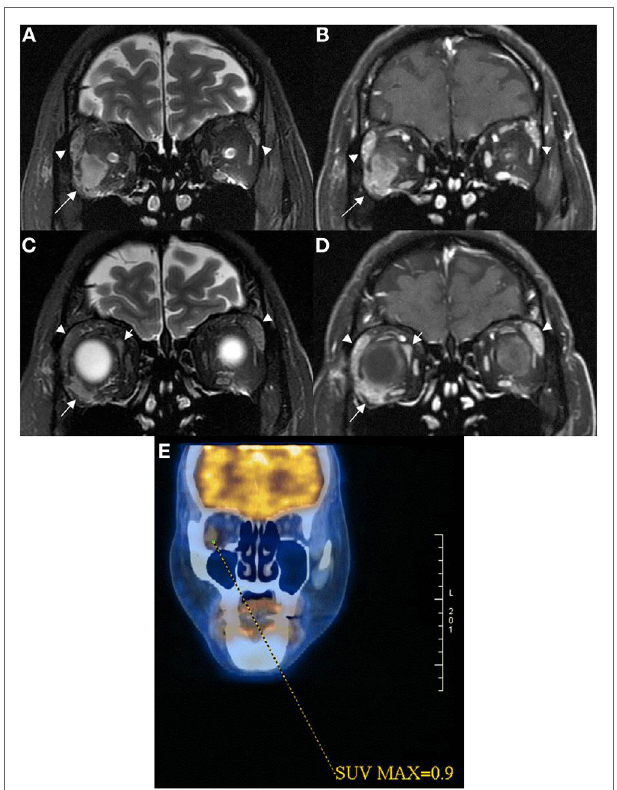
FIGURe 2 | Coronal MRI of patient 2 showed intraconal orbital mass lesion (arrow) with low T2W signal (a) and modest contrast enhancement (B) having a 0.9 SUV on 18 FDG PET image (e) . Coronal MRI more anteriorly showed extraconal orbital lesions (short and long arrows) with low T2W signals (C) with modest contrast enhancement (D) . One of the extraconal lesion infiltrated the outer lateral part of the right globe [long arrows in (C,D) ]. Lacrimal glands were enlarged [arrowheads in (a–D) ], and they demonstrated low T2W signals with modest contrast enhancement suggestive of lymphoid tissue infiltrate.